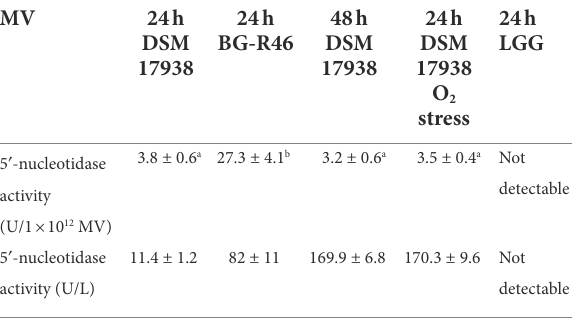
TABLE 2 5 ′ -nucleotidase activity of MV which was isolated from L. reuteri under different cultivation